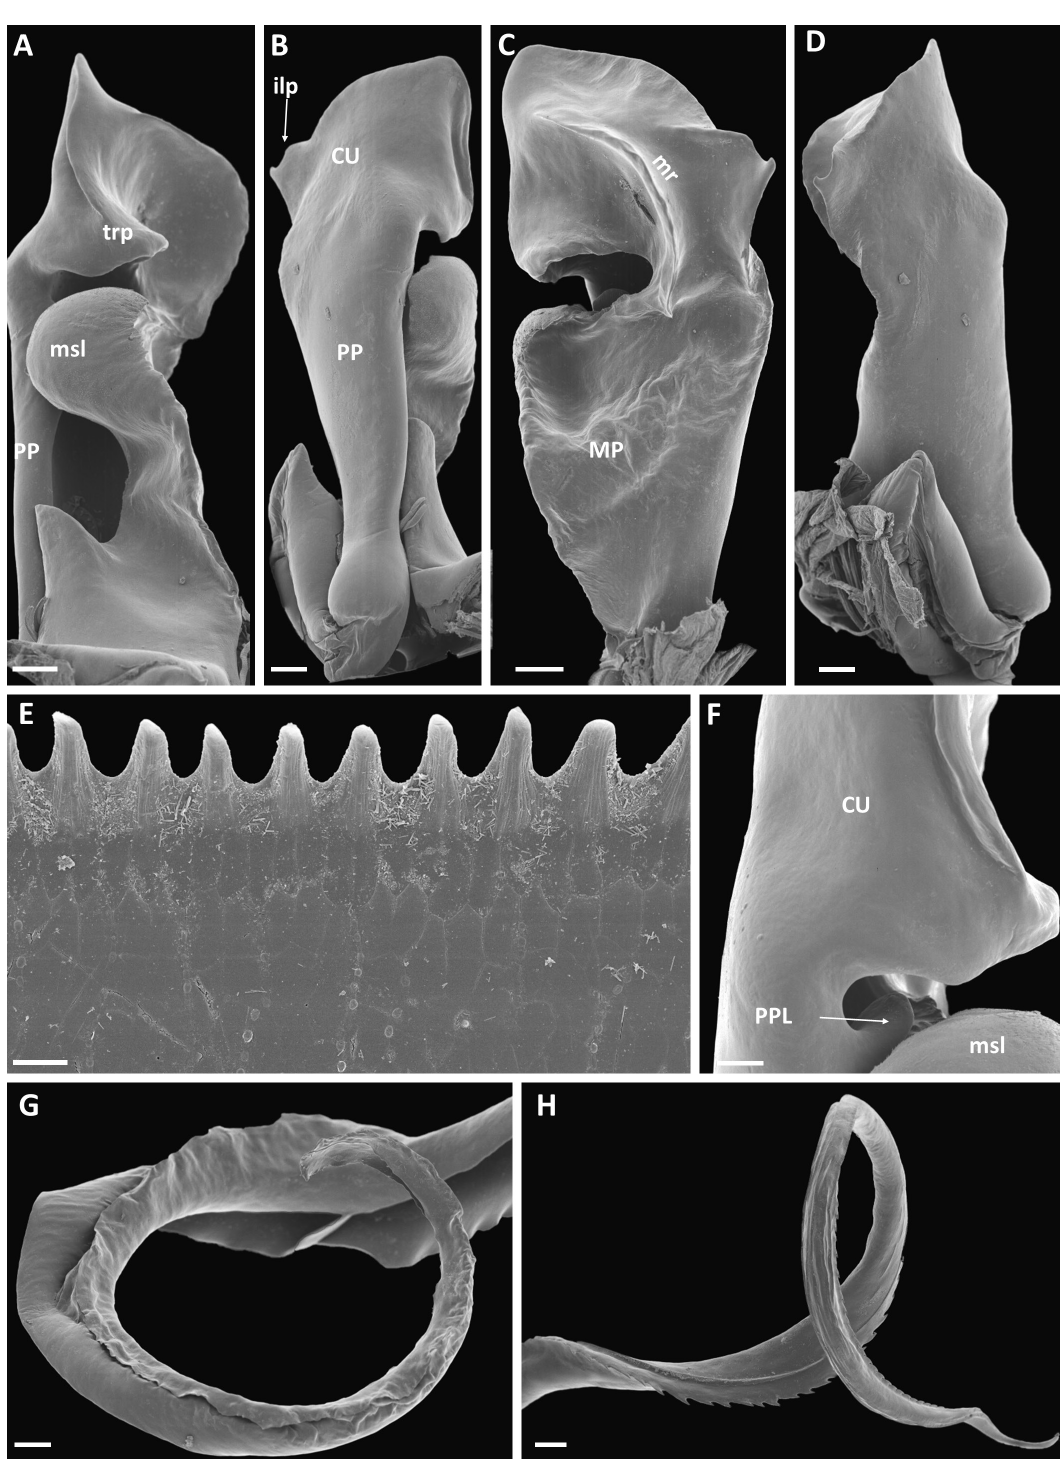
Fig. 48. Notogallanus mastacembalus gen. et sp. nov., holotype, ♂ (VMNH110632). A–D, F . Left gonopod coxa. A. Mesal view. B. Anterior view. C. Posterior view. D. Sublateral view. F. Detail of cucullus and proplica, showing proplical lobe. E . Midbody dorsal limbus. G–H . Left gonopod telopodite. G. Tip of telomere. H. Tip of solenomere. Abbreviations: CU = cucullus; ilp = irregular lateral process; MP = metaplica; mr = metaplical ridge; msl = metaplical subspherical lobe; PP = proplica; trp = triangular process. Scale bars: A–D = 0.1 mm; E = 0.01 mm; F–H = 0.05